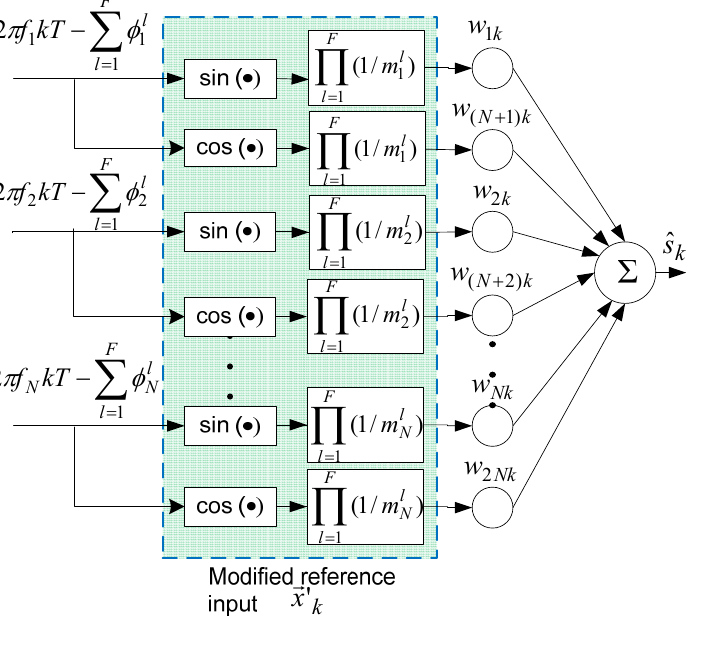
Figure 5. The block diagram of the compensation using the modified reference input in